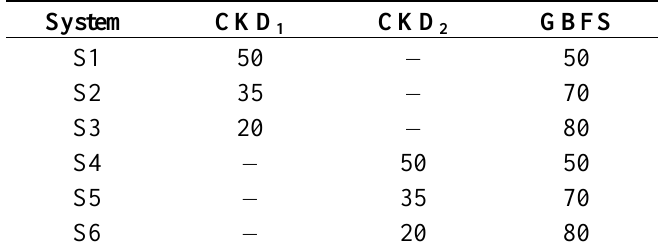
Table 4. Hydratory systems composition (wt